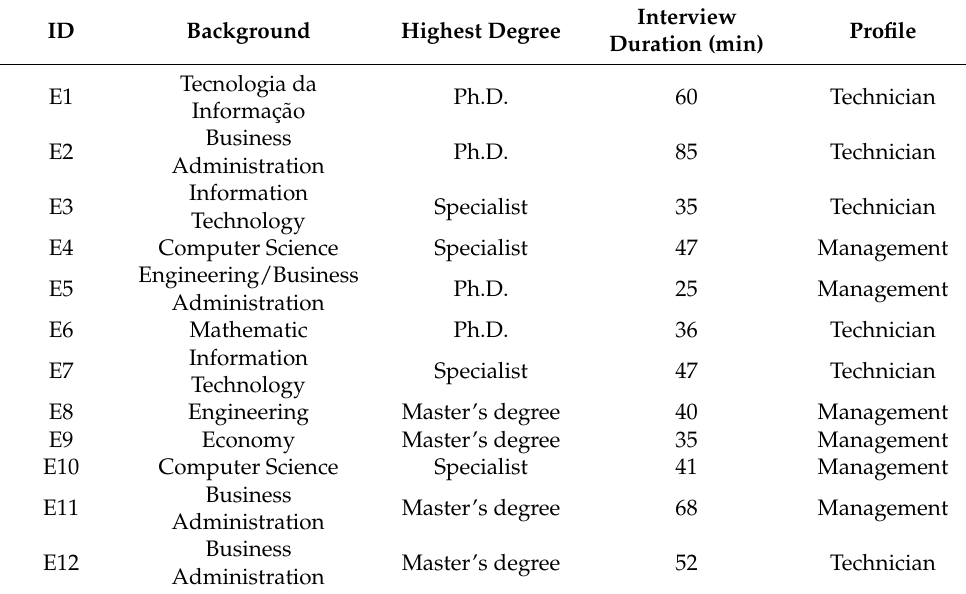
Table 2. Description of